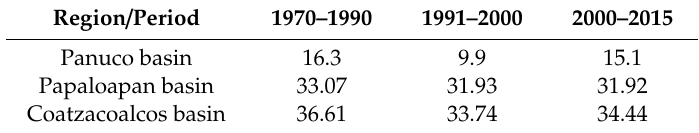
Table 1. Values of P95 (mm / day) for three di ff erent periods for the three regions under analysis.